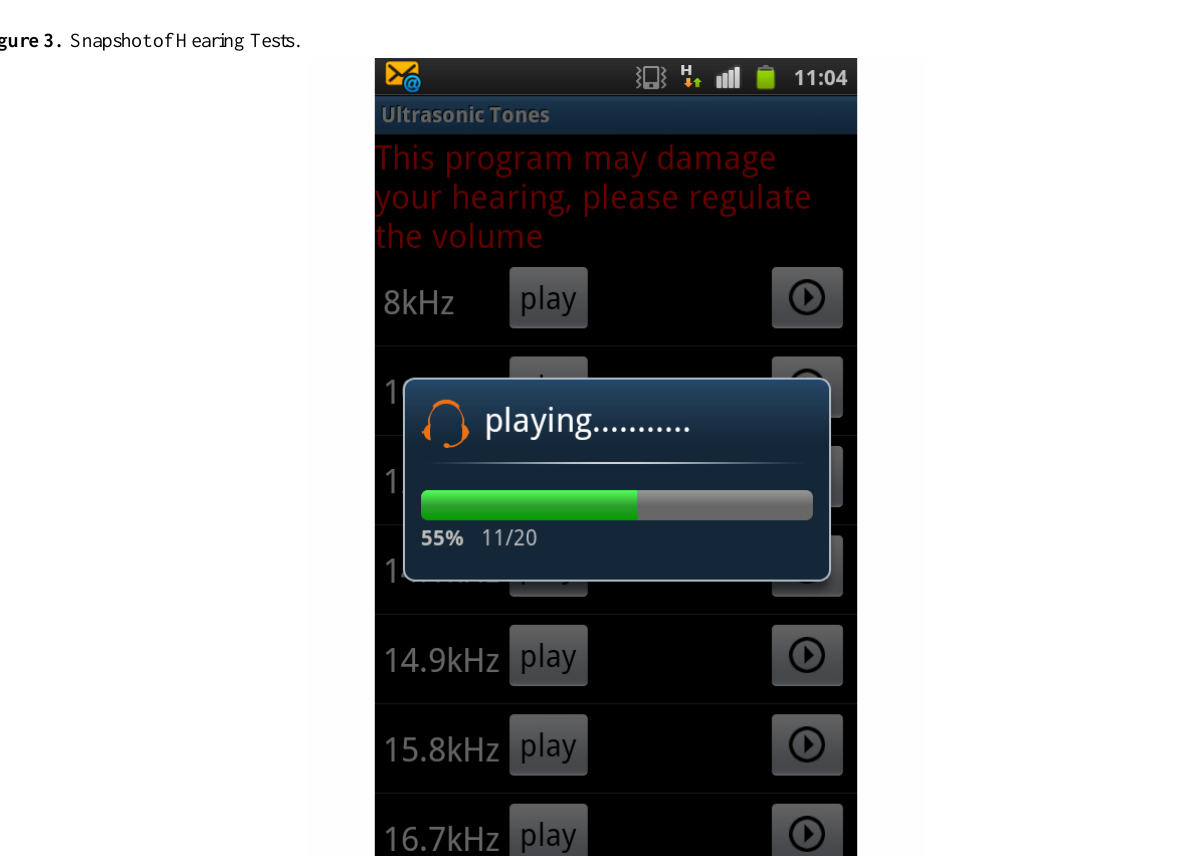
Figure 3. Snapshot of Hearing